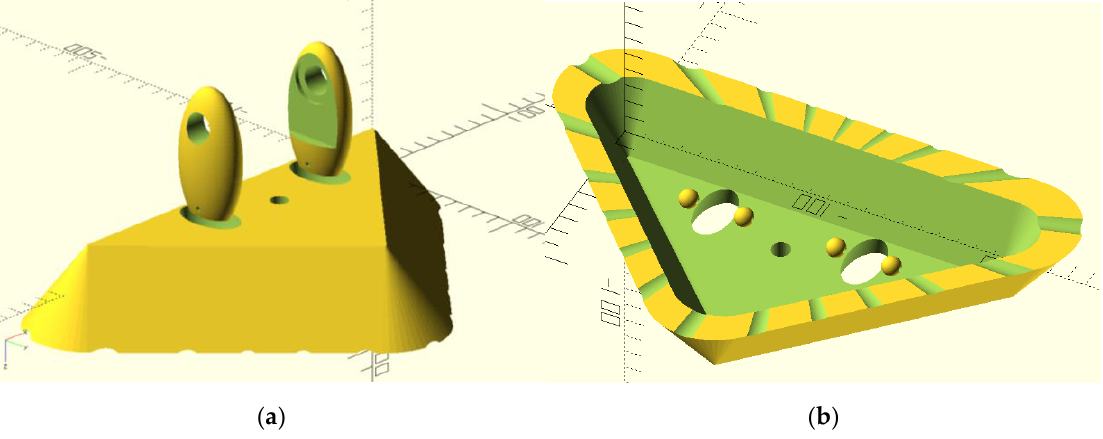
Figure 8. Rendering of OpenSCAD design of replacement steamer ( a ) top view and ( b ) bottom view.